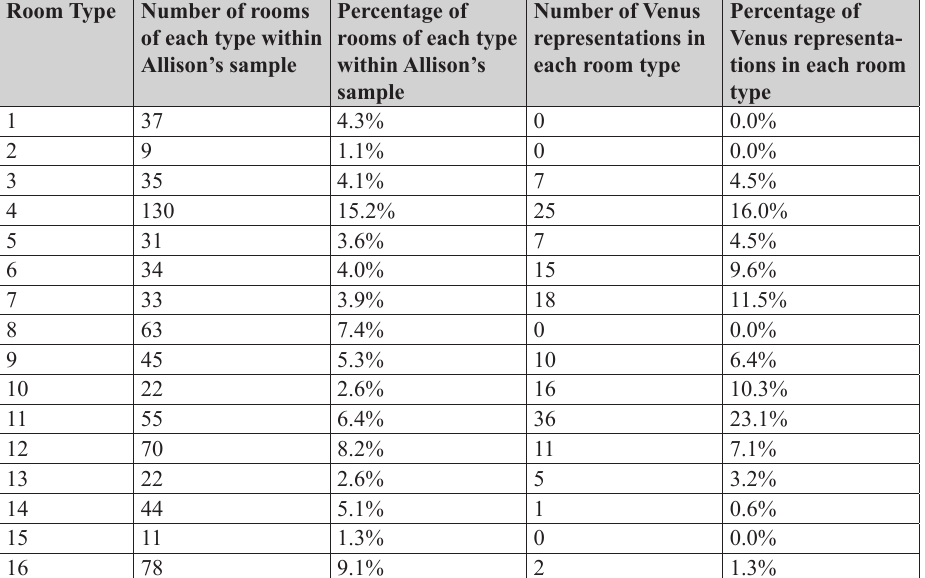
Table 2: The frequency of each room type and corresponding percentage within Allison’s (2004b) sam- ple of 30 Pompeian households in comparison to the frequency and percentage of Venus representations in each room type Room Type Number of rooms of each type